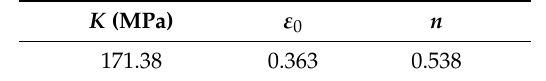
Table 2. Hollomon fitted coefficients from the RD tensile curve.